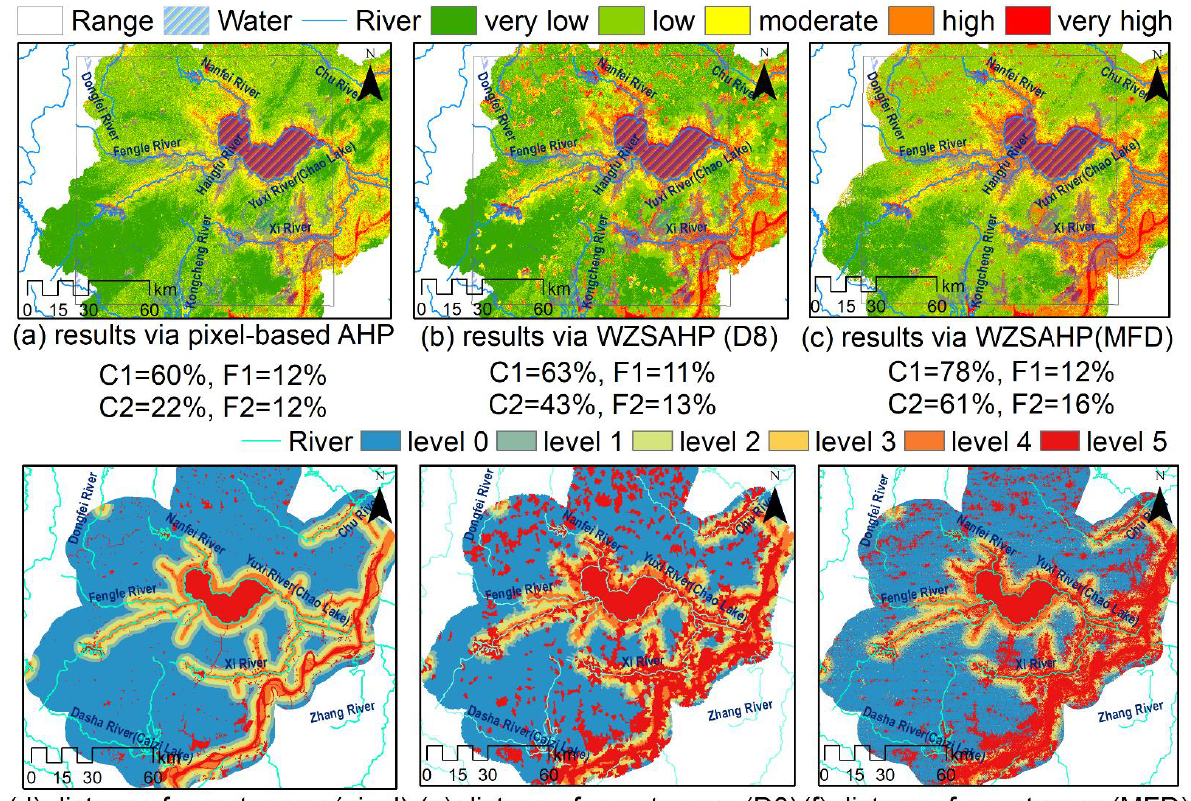
Figure 13. The GRWL distribution and the GRWL-based Distance from streams indicator in the study area. Figure ( a ) was the GRWL vectors and corresponding buffer results basing the attribute value of the width, figure ( b ) was the Euclidean distance from the GRWL buffer border, and figure ( c ) was the ordinary water bodies overlying the GRWL buffer layer and the ranked “ Distance from streams ” indicator in figure ( d ) was derived by GRWL and normal water range.